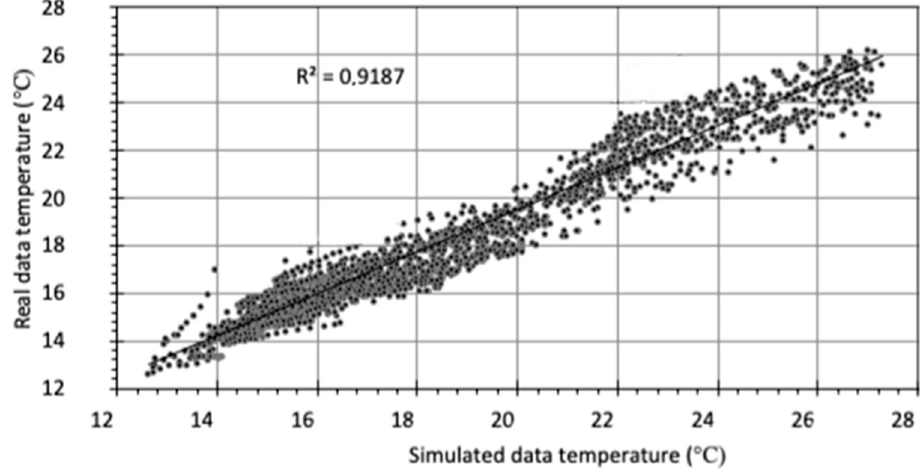
Figure 3. Relationship between the measured and simulated indoor air temperature in the LSF test cell for the entire monitored period.